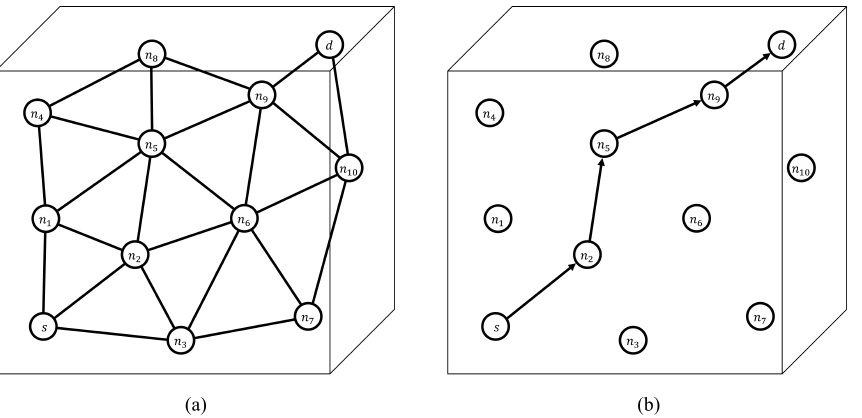
Figure 6. Example of P2P route discovery case for explanation of adaptive trickle timer operation. ( a ) The network node deployment and node connectivity. Nodes s and d are the source and desti- nation, respectively. The solid arrows in ( b ) construct the route first discovered by both P2P-RPL and GVA-P2P-RPL.